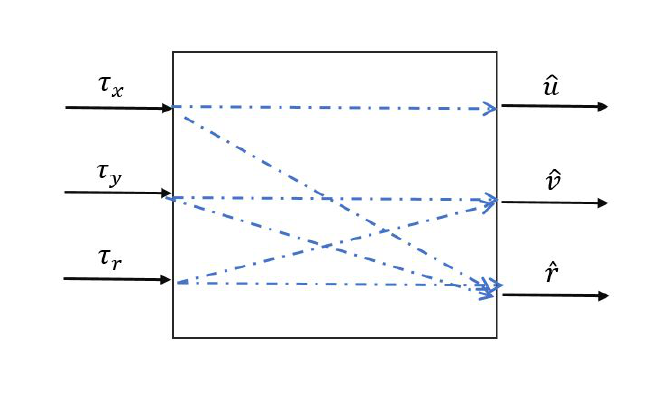
Figure 3. Corelaction with signals.